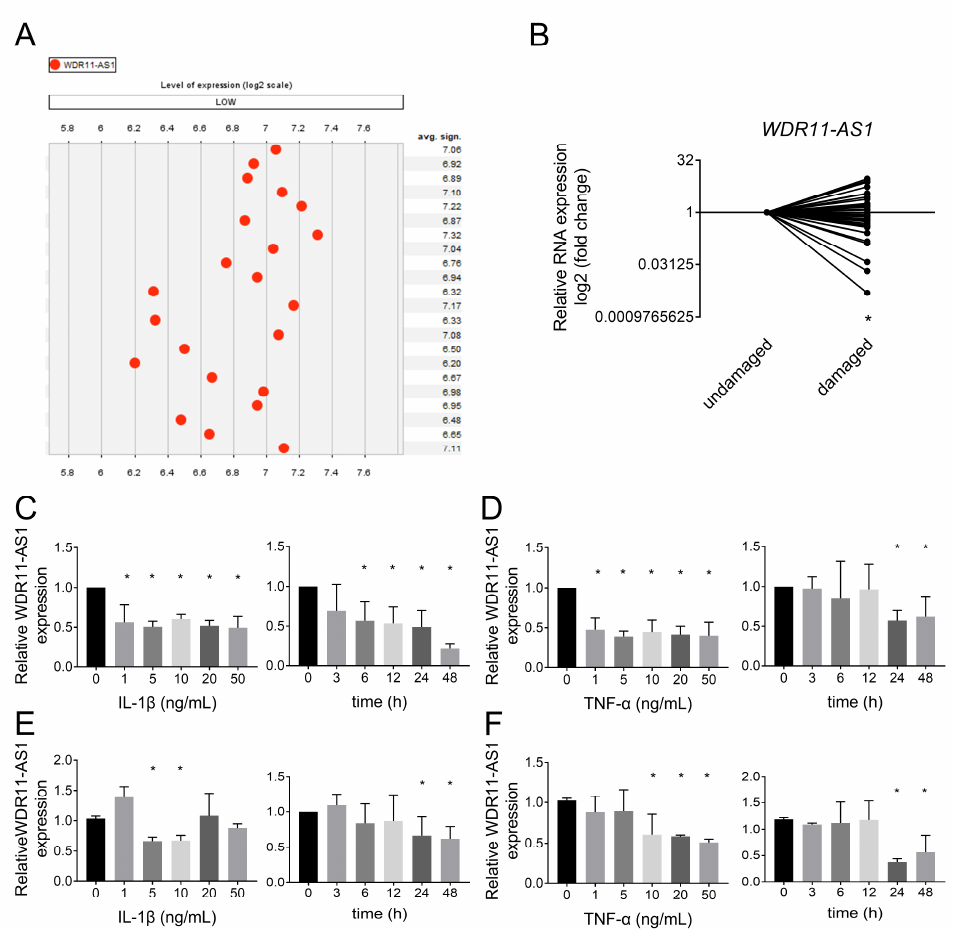
Figure 1. Poor expression of lncRNA WDR11-AS1 in OA cartilage tissues and proinflammatory cytokines stimulated chondrocytes. ( A ) LncRNA WDR11-AS1 levels were extracted from human osteoarthritic cartilage compared with nonosteoarthritic cartilage by the Genevestigator database (E-MTAB-4304, E-MTAB-6266, E-MTAB-7313, GSE117999, GSE114007, GSE110606). ( B ) LncRNA WDR11-AS1 levels were determined by RT-qPCR in cartilage tissues of undamaged and damaged regions in OA patients; n = 39. ( C , D ) Determination of lncRNA WDR11-AS1 levels in primary chondrocytes stimulated with 10 ng/mL IL-1β ( C , right) or TNF-α ( D , right) for 0, 3, 6, 12, 24, or 48 h and 0, 1, 5, 10, 20, or 50 ng/mL IL-1β ( C , left) or TNF-α ( D , left) for 24 h by RT-qPCR assay. ( E , F ) Determination of lncRNA WDR11-AS1 levels in SW1353 cells stimulated with 10 ng/mL IL-1β ( C , right) or TNF-α ( D , right) for 0, 3, 6, 12, 24, or 48 h and 0, 1, 5, 10, 20, or 50 ng/mL IL-1β ( C , left) or TNF-α ( D , left) for 24 h by RT-qPCR assay. * p < 0.05, damaged vs. undamaged ( B ), the stimulated group vs. the untreated group (0 ng/mL or 0 h) ( C – F ). For ( B ), the lncRNA WDR11-AS1 levels in cartilage tissues were compared using a paired t -test. For ( C – F ), the experiments were repeated three times. The measurement data are expressed as the mean ± standard deviation, and were analyzed by Mann–Whitney U test.